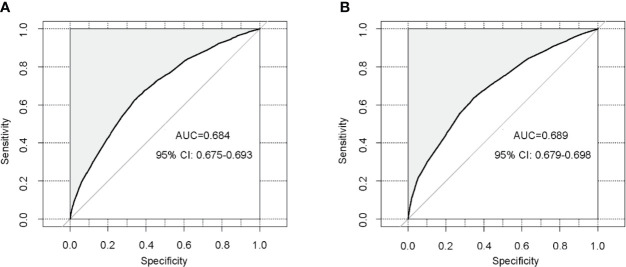
Validation of the nomogram using receiver operating characteristic curves. (A) Internal validation in the training cohort; (B) External validation in the validation cohort. AUC: area under curve; CI: confidence intervals.